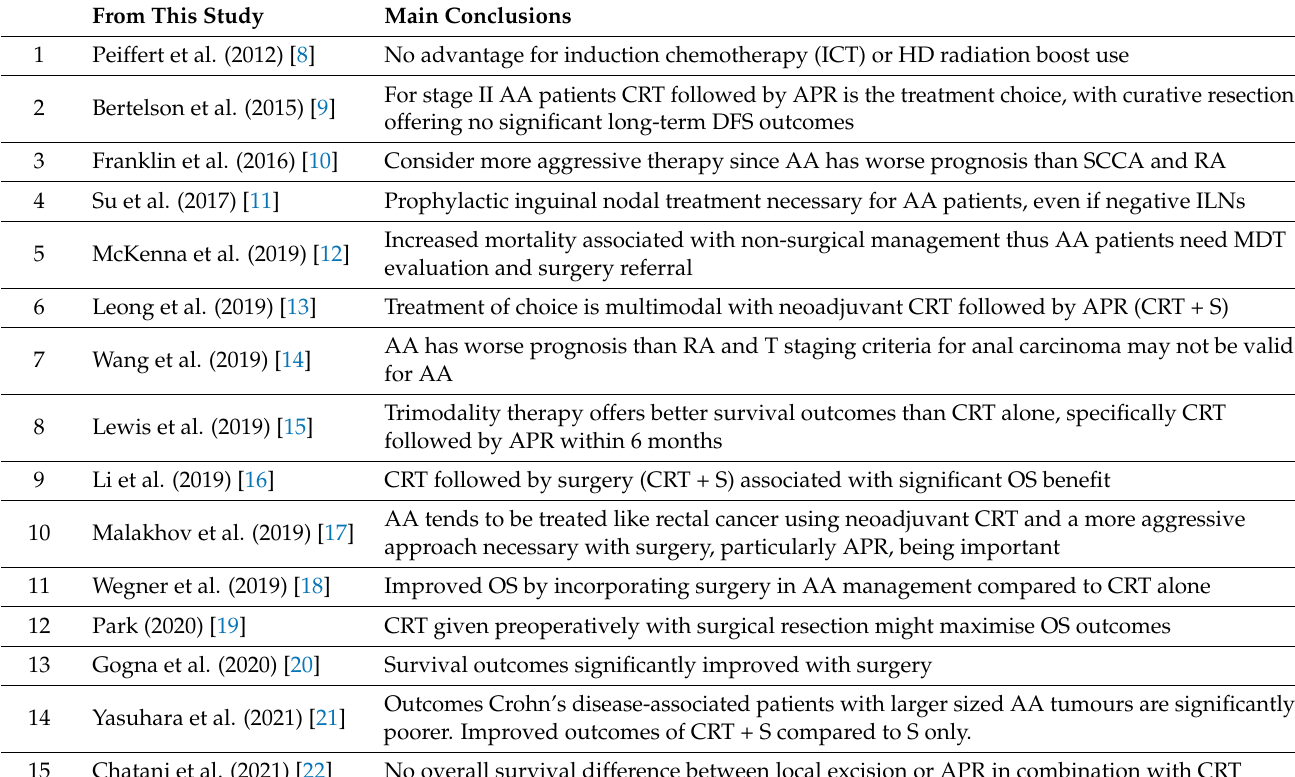
Table 3. Main conclusion from each study included in this systematic